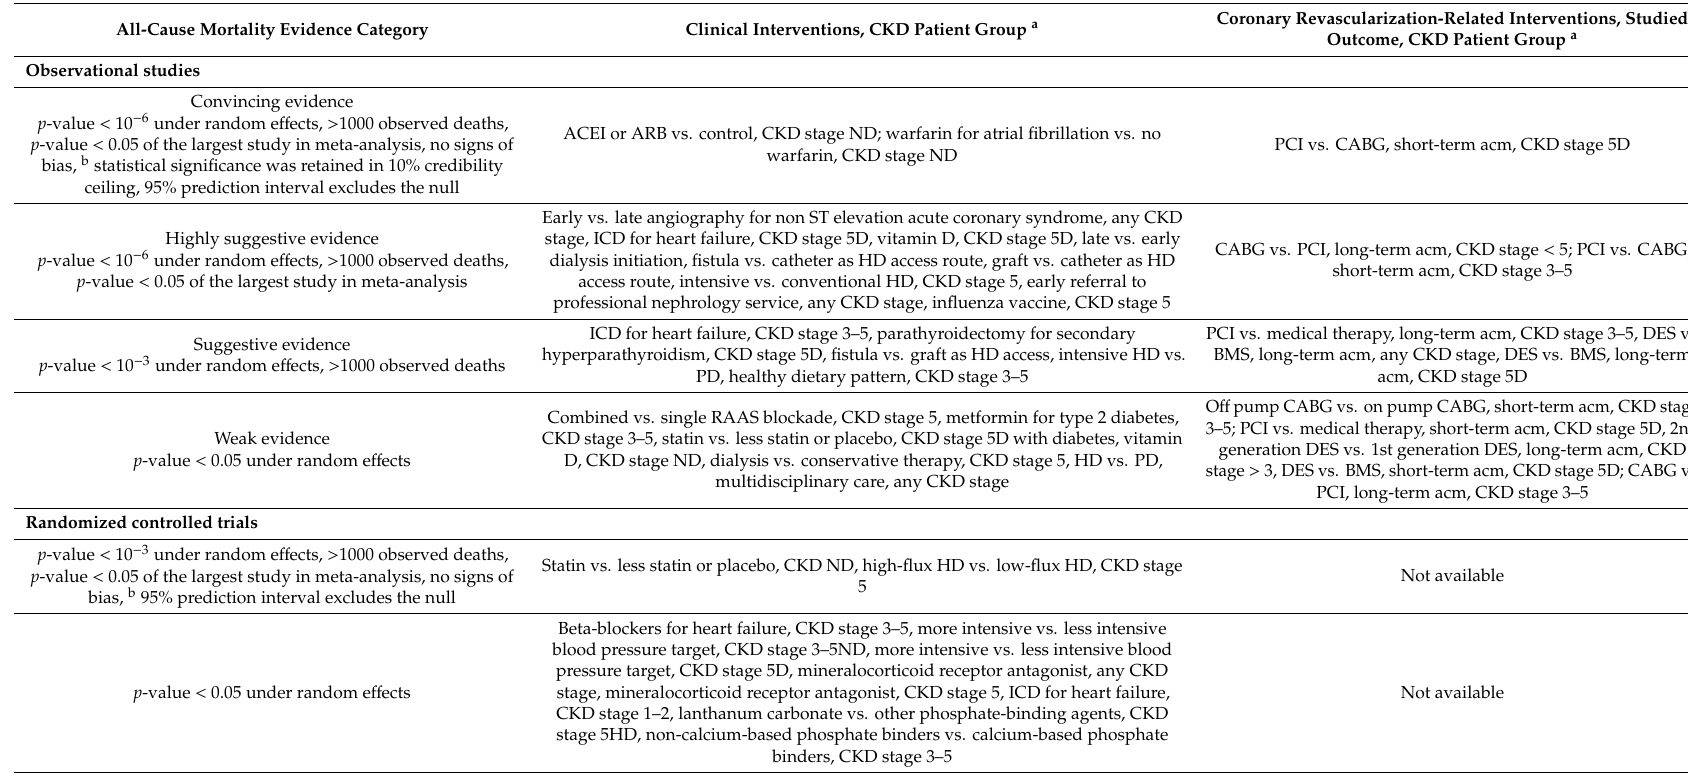
Table 1. Summary of evidence grading for associations between clinical intervention and all-cause mortality of patients with chronic kidney disease (for associations having p -value <